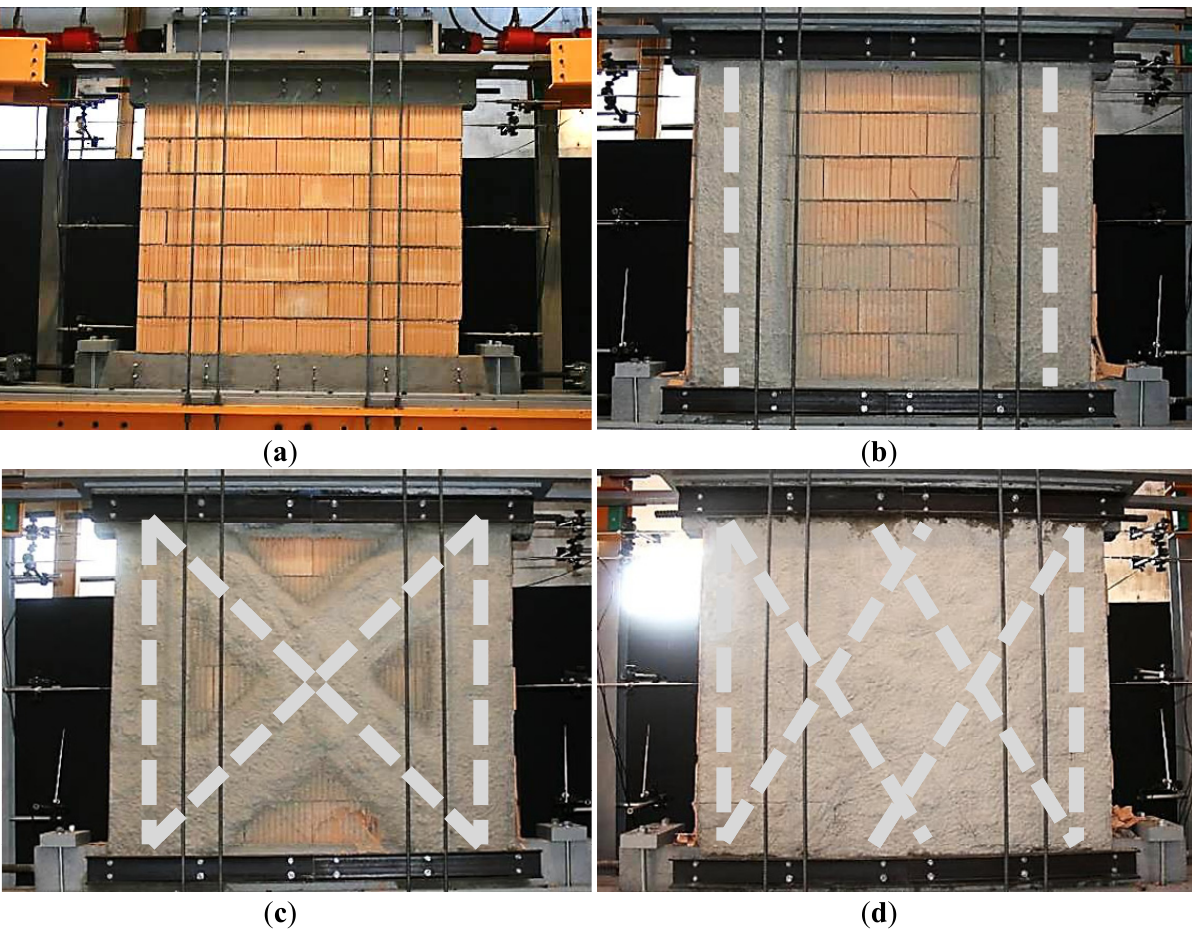
Figure 3. Different configurations of carbon mesh for retrofitting masonry walls